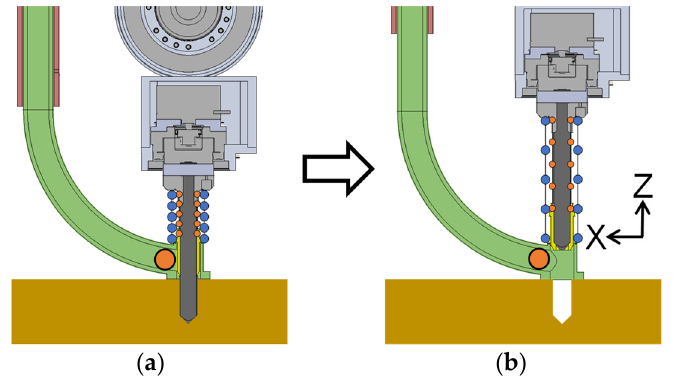
Figure 12. ( a ) Hole-opening, ( b ) Seed ball discharge. Sowing action.